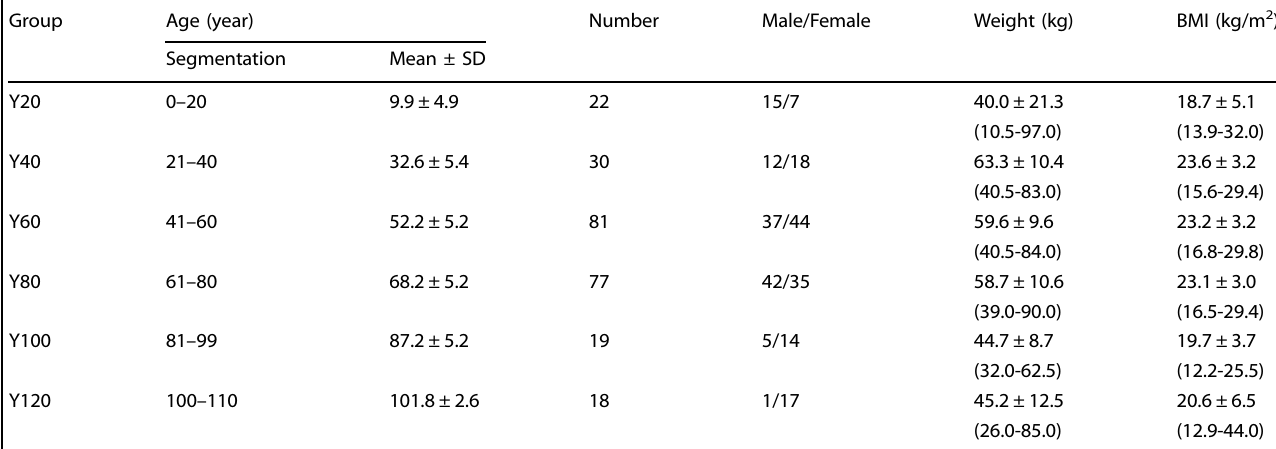
Table 1. Demographical characteristics in world ’ s longevity townshipthe Jiaoling, China.